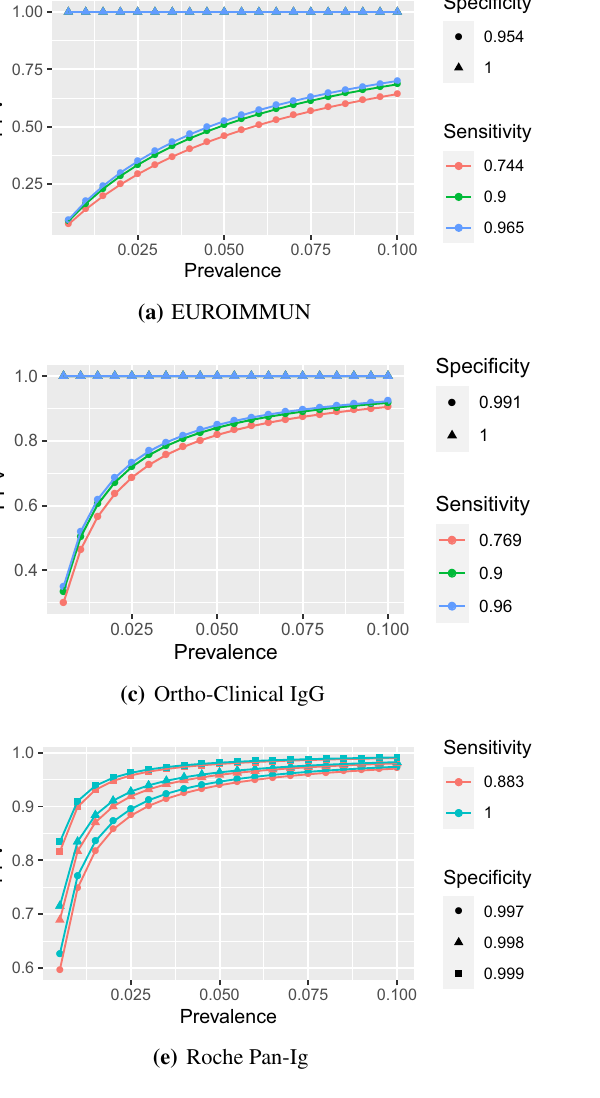
Figure 4. PPV by prevalence (up to 10%) for FDA tests